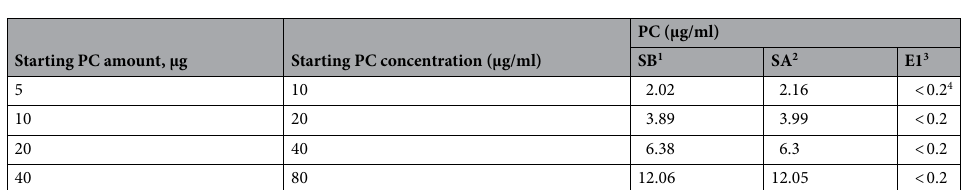
Starting PC amount, µg Starting PC concentration